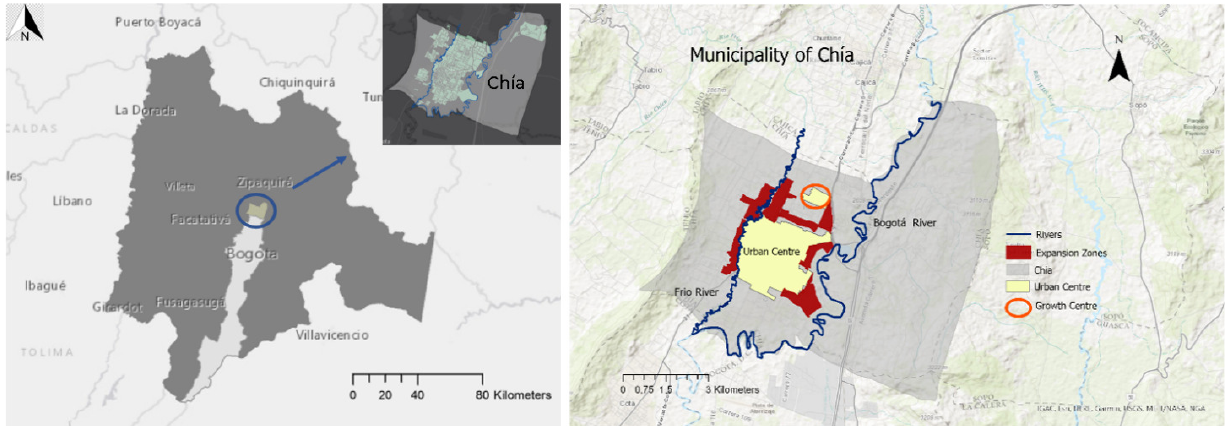
Figure 1. Location of the municipality of Chía (left) and the map of the city (right). located in the area bordering the north of Bogotá.